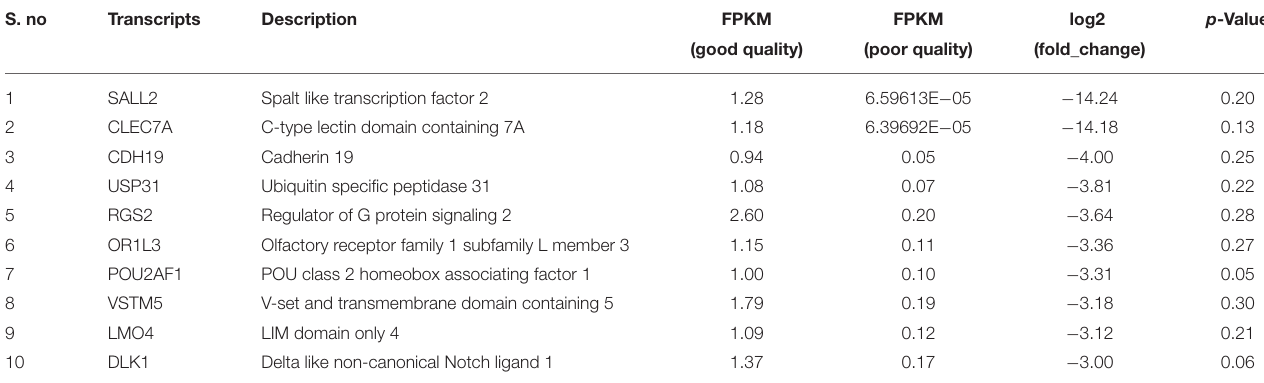
TABLE 3 | Top 10 downregulated transcripts in poor compared with good quality semen. S.